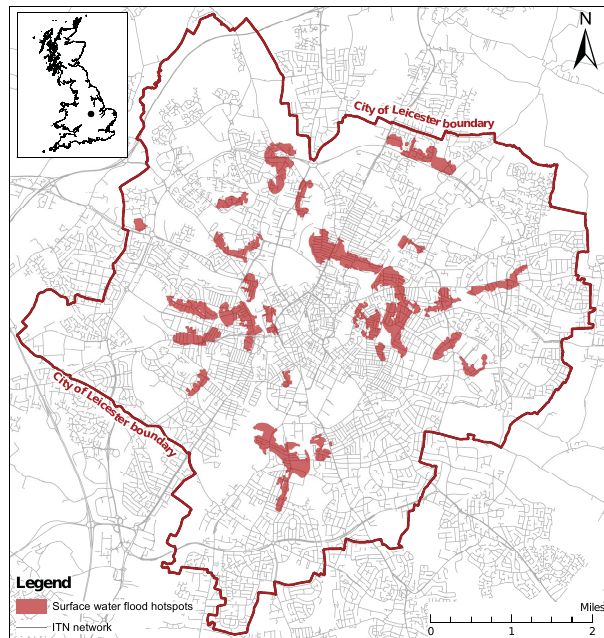
Figure 1. Distribution of the 26 locations identified as surface water hotspots in Leicester,